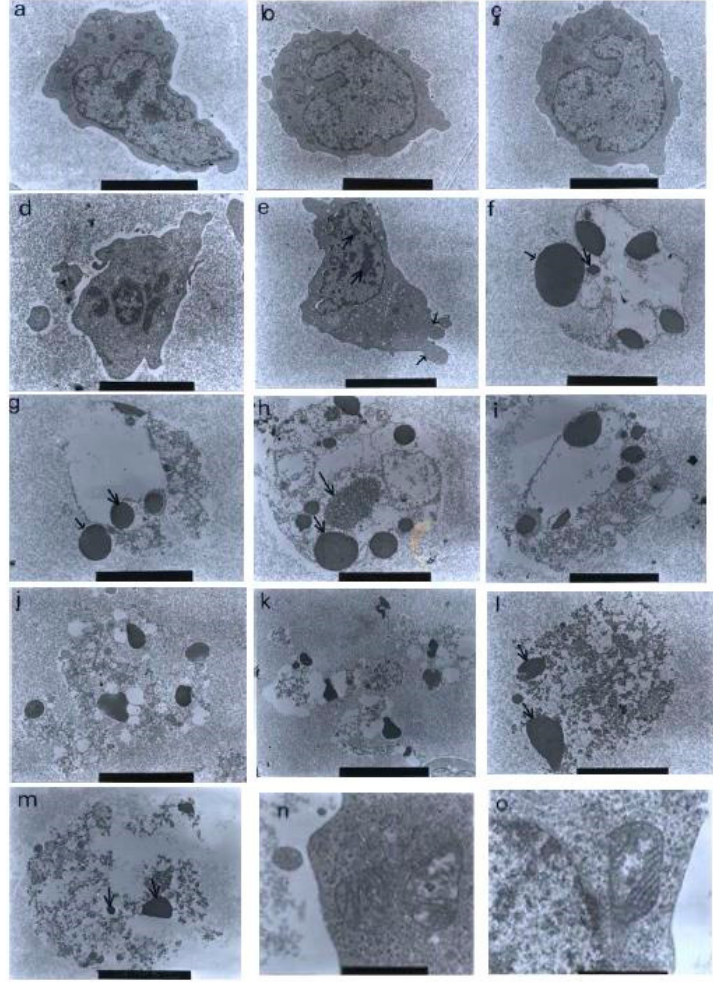
Figure 10. Transmission electron micrographs of CEM-SS cells without treatment (control) or treated with different concentrations of nordamnacanthal for 24 h. ( a , b ) Unaffected control cells with irregular shapes. The nuclei were large and chromatin was evenly distributed in the nuclear compartments (6000 × magnification). Cells treated with ( c ) 1 µ g/mL (7000 × magnification) and ( d ) 3 µ g/mL (8000 × magnification) of nordamnacanthal showing no morphological changes compared to the control. ( e ) Cell treated with 10 µ g/mL of nordamnacanthal showing the earliest evidence of apoptosis. The chromatin started to condense (big arrows), and the blebs began to form (small arrows). The surface microvilli totally vanished (5000 × magnification). ( f , g ) Cells treated with 10 µ g/mL with obvious cell and nuclear convolution accompanied by extensive budding, producing distinct nuclear fragments, different in size and chromatin content. The condensed chromatin occupied the whole of the cross-sectional area in some of the fragments (small arrow) and was confined to peripheral crescents in others (big arrow) (7000 × magnification). ( h , i ) Remnants of the nucleolus were apparent in the nuclei and the nuclear fragments in some planes of the section, appearing in two forms: clusters of dispersed granules (long arrow) and compact granular masses that were closely opposed to the inner surfaces of the condensed chromatin (short arrow) (from 30 µ g/mL treatment) (7000 × magnification). ( j ) The protuberances on the cell surface began to separate (from 30 µ g/mL treatment) (6000 × magnification). ( k ) A cluster of apoptotic bodies containing dense and lucent nuclear fragments and well-preserved organelles (from 30 µ g/mL treatment) (6000 × magnification. ( l , m ) Advanced stage of degeneration of apoptotic bodies that could still be recognized by the presence of typical nuclear fragments (arrows) (from 30 µ g/mL treatment) (8000 × and 10,000 × magnification, respectively). ( n ) Mitochondria of control cell (40,000 × magnification). ( o ) Unaffected mitochondrion from cell treated with 30 µ g/mL of nordamnacanthal (40,000 ×